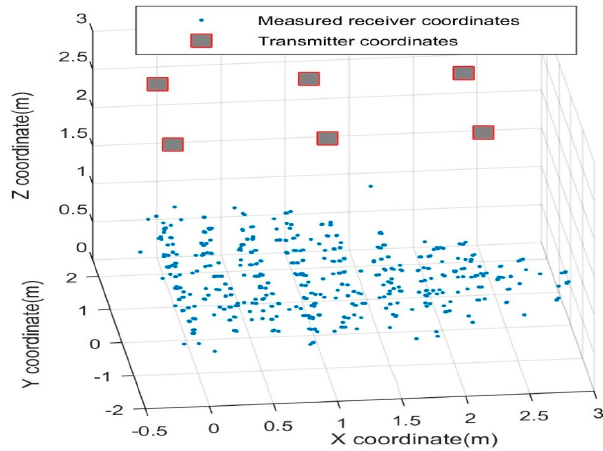
Figure 11. 3D distribution of the measured receiver coordinates.